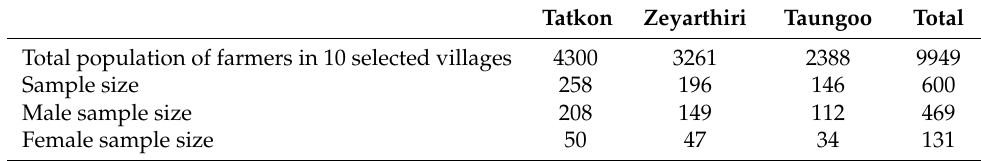
Table 1. Sample size determination.